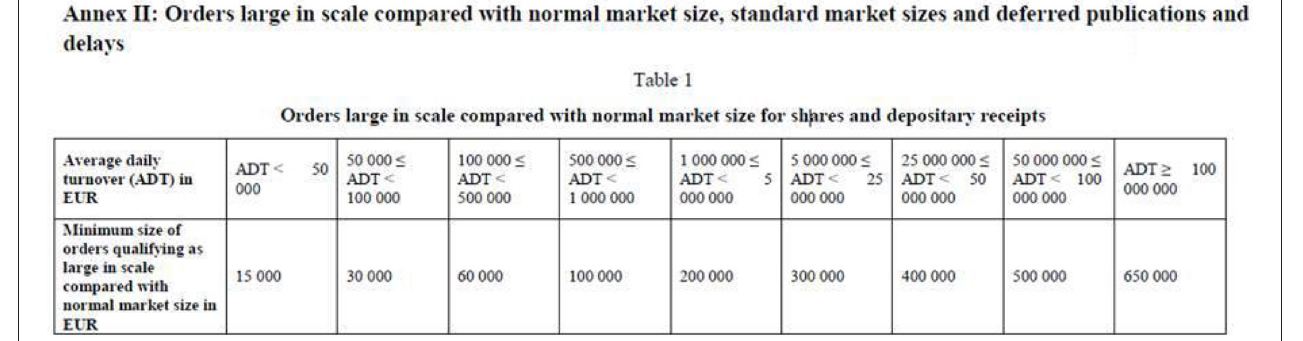
Frontiers in Blockchain |